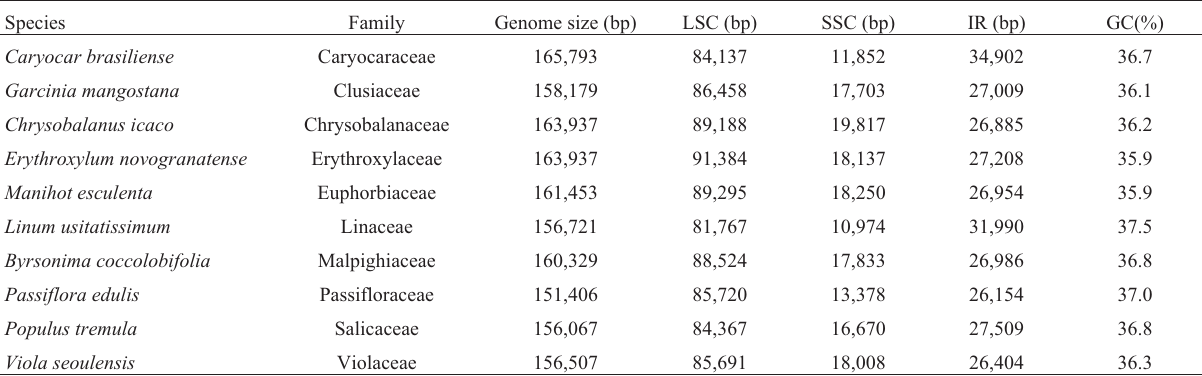
Table 1 - Comparative chloroplast genome structural features in 10 species from Malpighiales order. LSC: Large Single Copy region; SSC: Small Single Copy region; IR: Inverted Repeats regions and bp: base pair.